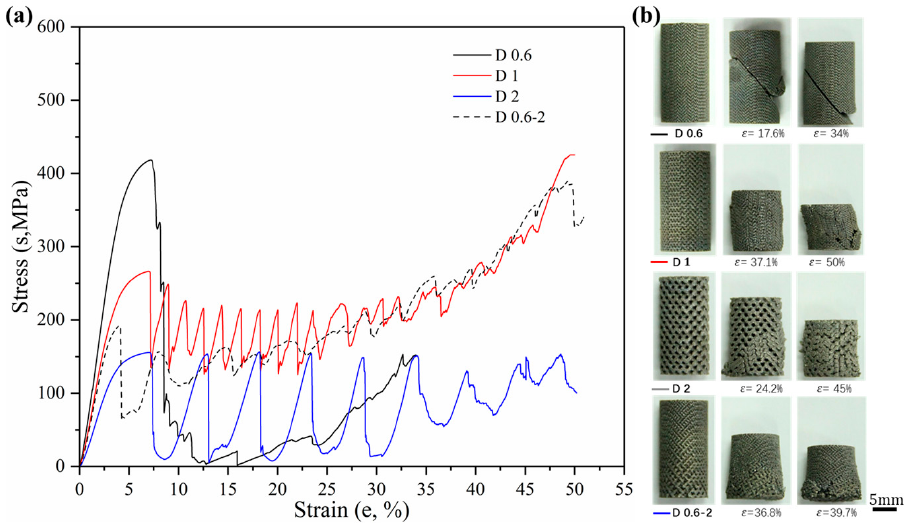
Figure 10. ( a ) Compressive stress-strain curves of Diamond gradient in cell-size ranging from 0.6 to 2 mm, and ( b ) video frames at the corresponding strain from the compression.